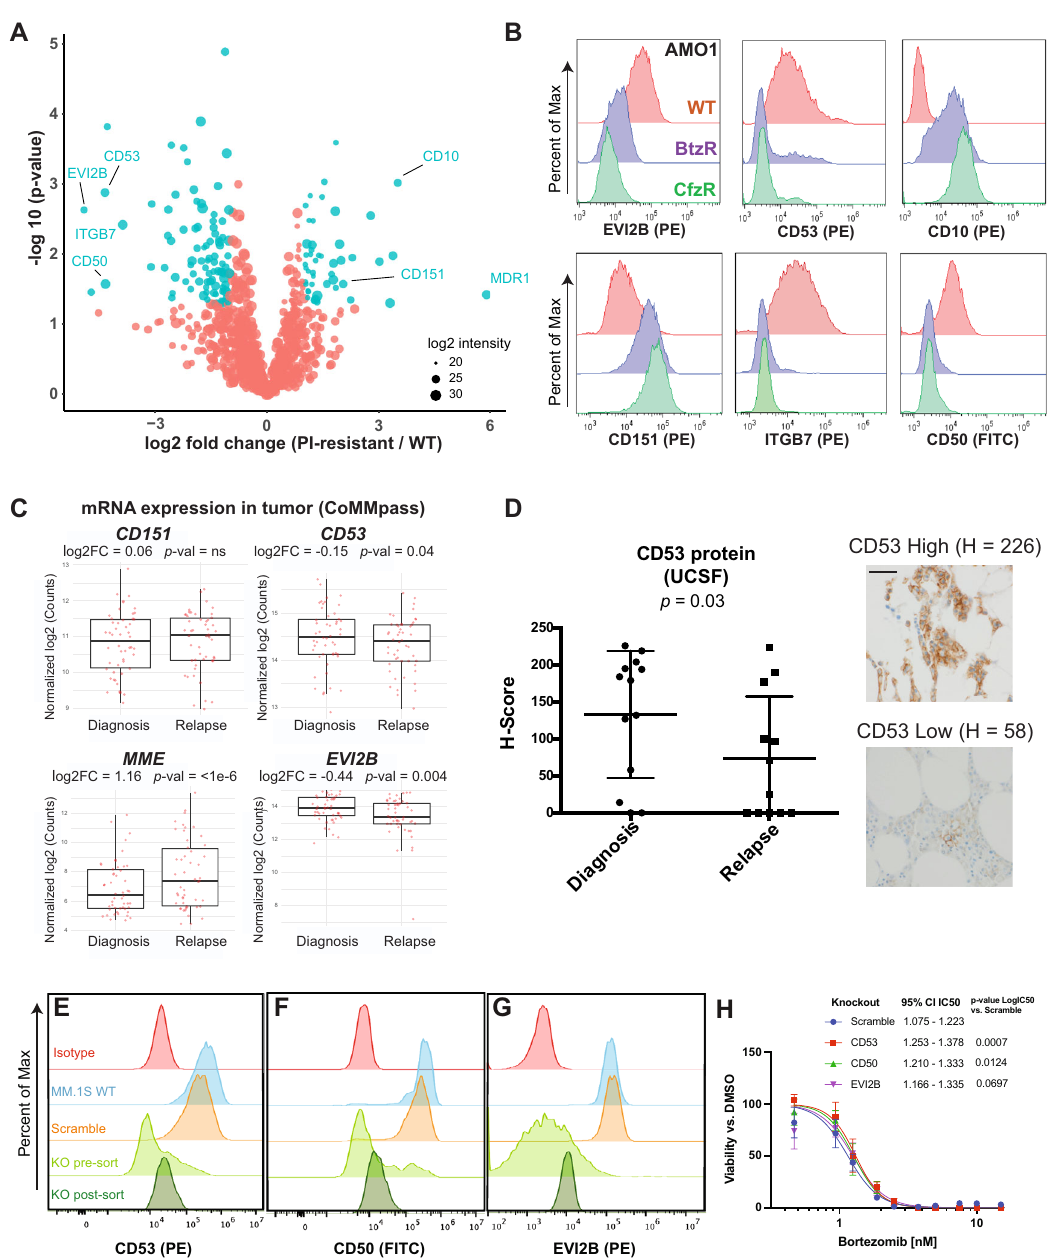
Fig. 3 De fi ning a myeloma surface signature of proteasome inhibitor resistance. A Cell surface proteomics was performed on evolved bortezomib- resistant (BtzR) and car fi lzomib resistant (CfzR) myeloma cell lines (AMO1 BtzR ( n = 3); AMO1 CfzR ( n = 3), L363 BtzR ( n = 2), L363 CfzR ( n = 3), RPMI- 8226 BtzR ( n = 1)) and aggregated in comparison to wild-type cell lines (AMO1 ( n = 3), L363 ( n = 2), RPMI-8226 ( n = 1)), n denotes number of biological replicates. Signi fi cantly changed proteins in PI-resistant lines shown in blue (log 2 -fold change > |1|; p < 0.05). Source data in Supplementary Data 3. B Validation by fl ow cytometry of most-changed surface proteins in AMO1 cells. Representative data of n = 2 independent experiments. C mRNA data in the MMRF CoMMpass database (Release IA14) from paired diagnosis and fi rst-relapse tumor cells ( n = 50), where all patients had received a PI as part of their induction regimen. p -value by two-sided t -test. Upper and lower hinges correspond to 25 and 75 percentiles, upper and lower whiskers extend to highest values within 1.5*IQR of the hinge, and center line indicates the median. D Immunohistochemistry for CD53 on myeloma plasma cells in bone marrow core biopsies from UCSF patients before and after Btz treatment ( n = 13 patients). H-scoring (see “ Methods ” ) averaged from two independent hematopathologists (E.R. and S.P.). Magni fi cation = ×60, scale bar length = 100 µ m. Error bars represent + / − SD and center line represents the mean. p -value by two-sided t -test. E – G Flow cytometry illustrating knockout of CD53 ( E ), CD50 ( F ), and EVI2B ( G ) in MM.1S cells. Representative of n = 2 technical replicates. H MM.1S engineered with knockouts and scramble guide RNA control were treated with Bortezomib for 48 h ( n = 3 technical replicates). 95% con fi dence interval of IC50s from Graphpad (see “ Methods ” ). Error bars represent + / − SD. p -values by Extra sum-of-squares F test. For D and H , source data are provided as a Source data fi